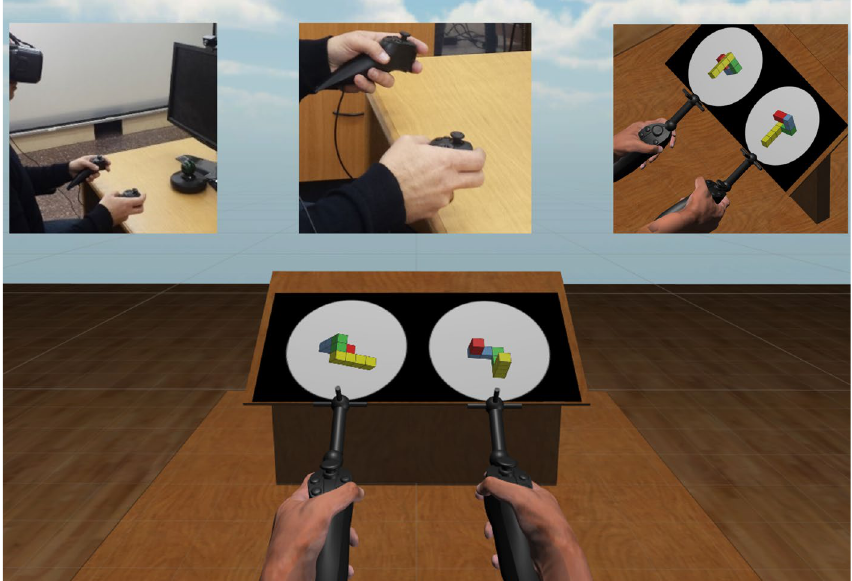
Figure 1. The virtual-reality scene from the participant’s point of view (bottom), and the experimental setup consisting of a virtual-reality headset, earphones and two handheld motion-tracking controllers (top-left), with the physical hands holding the physical controllers (top-middle) always experienced as posturally matching the virtual hands holding the virtual controllers (top-right).